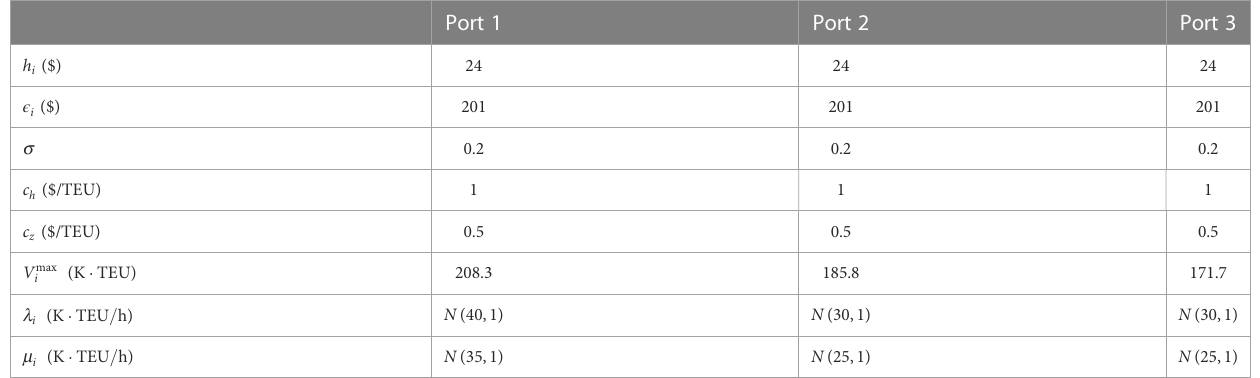
TABLE 2 Other data of the three